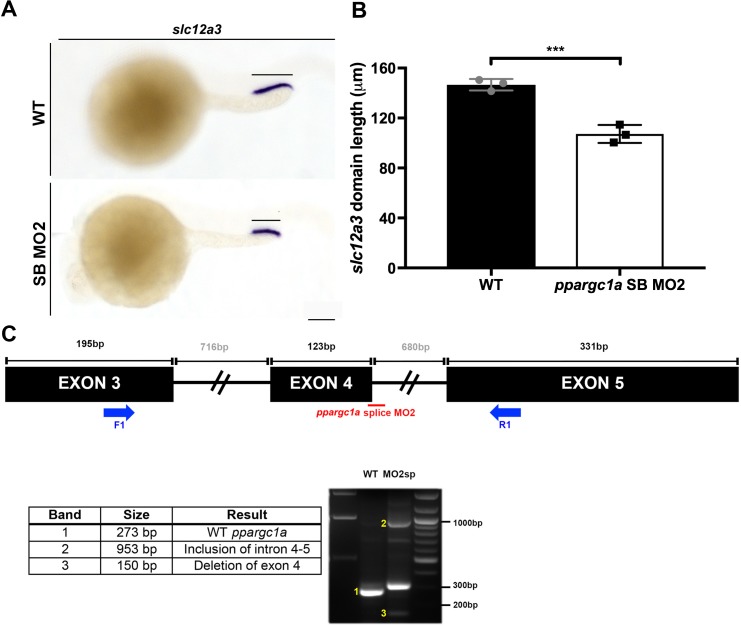
Loss of function via a ppargc1a splice blockingMO recapitulates the decreased DL phenotype seen in other loss of function tests.(A) WISH for slc12a3 (DL) in 28 ss WT (top) and splice blocking (SB) MO2 (bottom) with the graph (B) showing absolute length measurements of representative samples. Scale bar = 100 μm. (C) RT-PCR analysis revealed disrupted splicing of ppargc1a at the target site specified on the exon map schematic. Data are represented as ±SD, significant by t test, *** = p < 0.001.